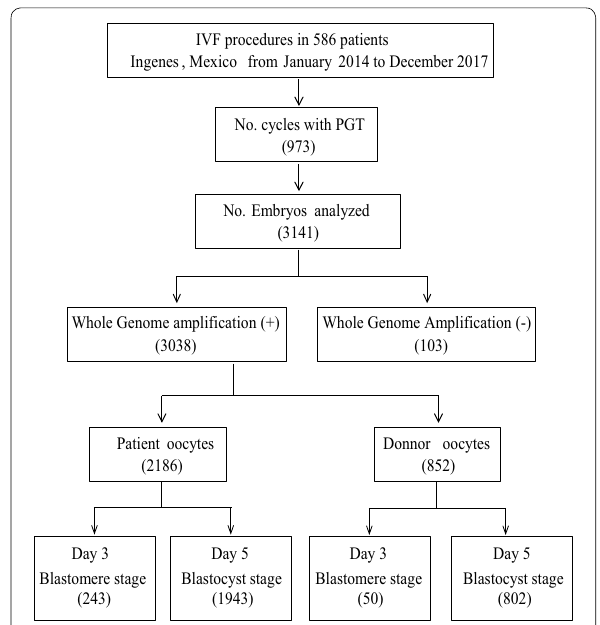
Fig. 1 Flow chart of embryo